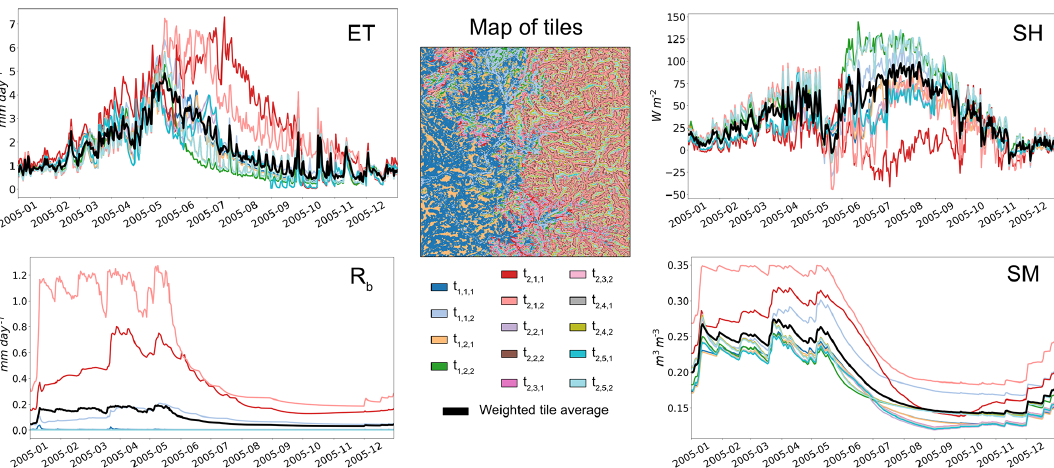
Figure 6. As an exploratory simulation, the LM4-HB model is run between 2002 and 2014 using 14 tiles assembled via HMC. The tile simulations are shown for evapotranspiration (ET), sensible heat flux (SH), baseflow ( R b ), and root zone soil moisture (SM) for 2005; the time series are color-coded to correspond to the 30m map of tiles. Each tile has a corresponding id t i,j,k , where i is the characteristic hillslope, j is the height band, and k is the intra-band cluster. For each variable, the tile-weighted average time series (macroscale estimate) is superimposed on the tile simulations for